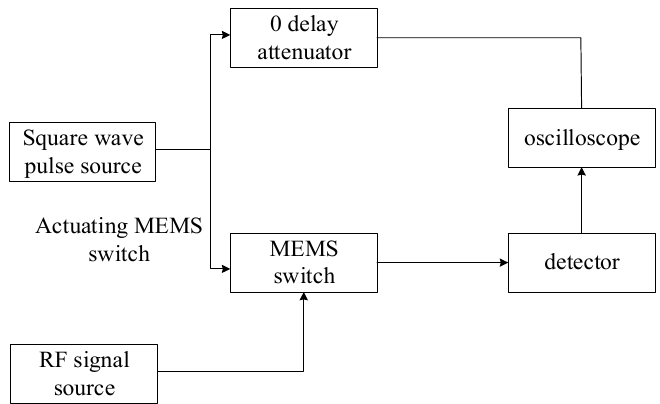
Figure 10. The equipment and connection.